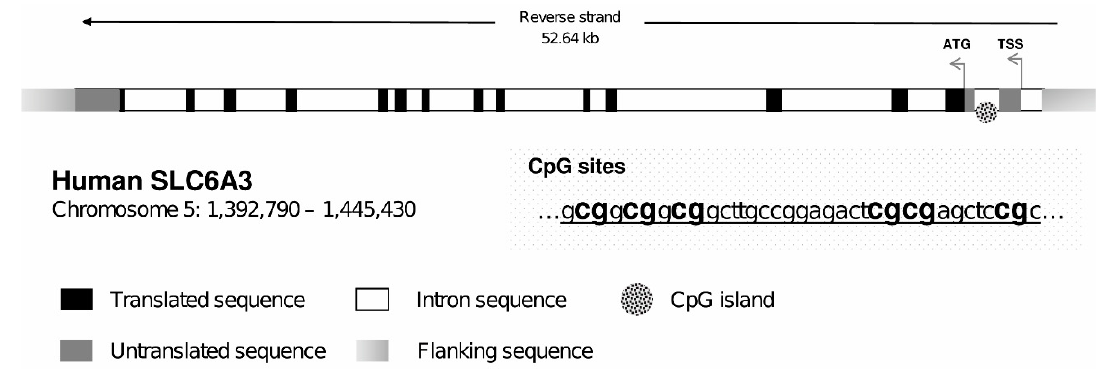
Figure 1. Schematic representation of human dopamine transporter (DAT1) gene. Positions of transcription start site (TSS), translation start code (ATG), and exons and introns are depicted. The CpG island containing the six CpG sites is reported from +712 to +746 relative to TSS, well within the first intron, located in the 5 ′ -untranslated region (UTR) of the gene. The first “cg” of the shown sequence is at position 1,444,717 (at +713), and 1,444,716 (at +714) on the reverse strand of chromosome 5. Taken from Tafani et al. [22].